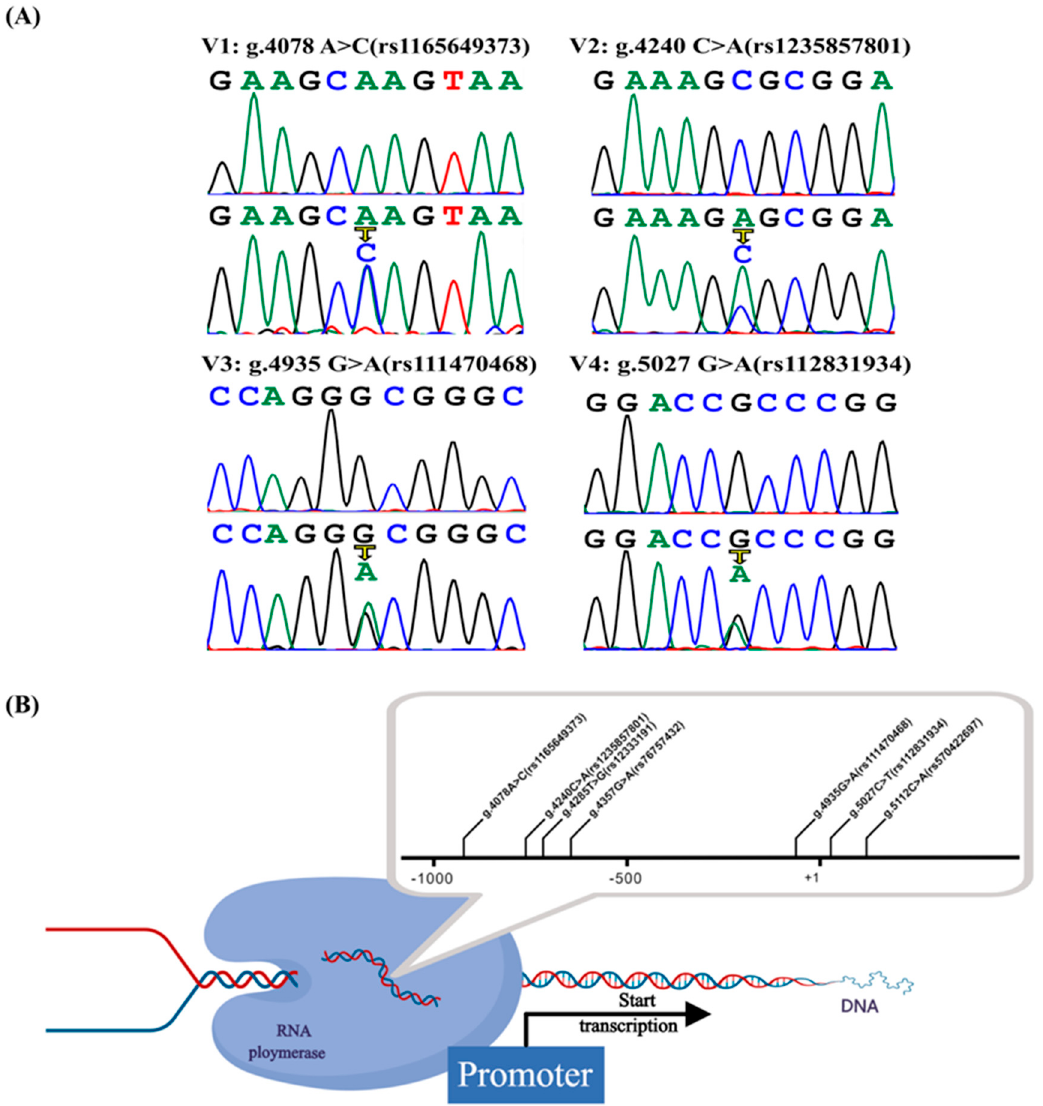
Figure 2. Mapping and Sanger sequencing map of CITED2 gene promoter variants. ( A ) The variants (V1–V4) of the CITED2 gene promoter found only in patients with atrial septal defect (ASD) are shown (g.4078A>C(rs1165649373), g.4240C>A(rs1235857801), g.4935C>T(rs111470468), g.5027C> T (rs112831934)). The top panel of V1-V4 shows the wild type and the bottom panel shows the heterozygous variant. ( B ) Regulatory variants of the CITED2 gene. The transcription start point is located at position 5001 of the first exon (+1), and these genetic variants are named according to the genomic sequence of the human CITED2 gene (Genbank Accession No.NG_016169.1), describing the location of the CITED2 gene promoter variants.